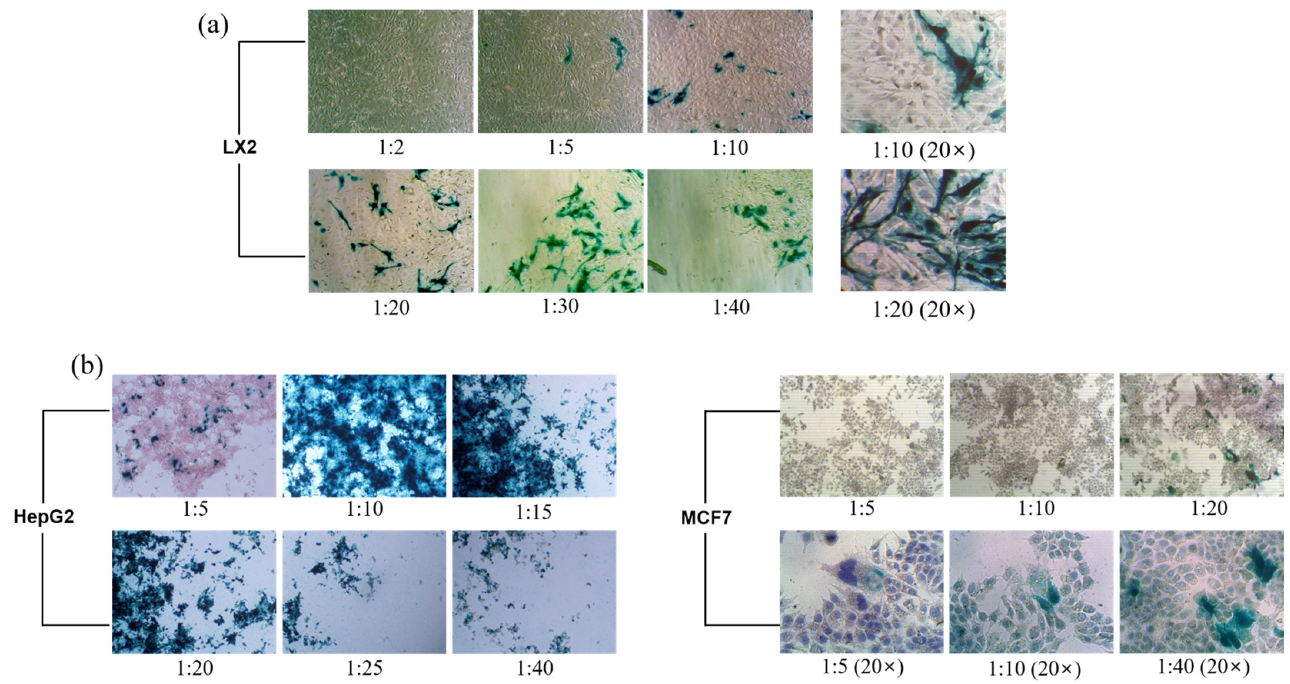
Figure 5. X-gal assay transfection images of ( a ) LX2 cells, and ( b ) HepG2 and MCF7 cells treated with pDNA-LPEI LTU NPs.